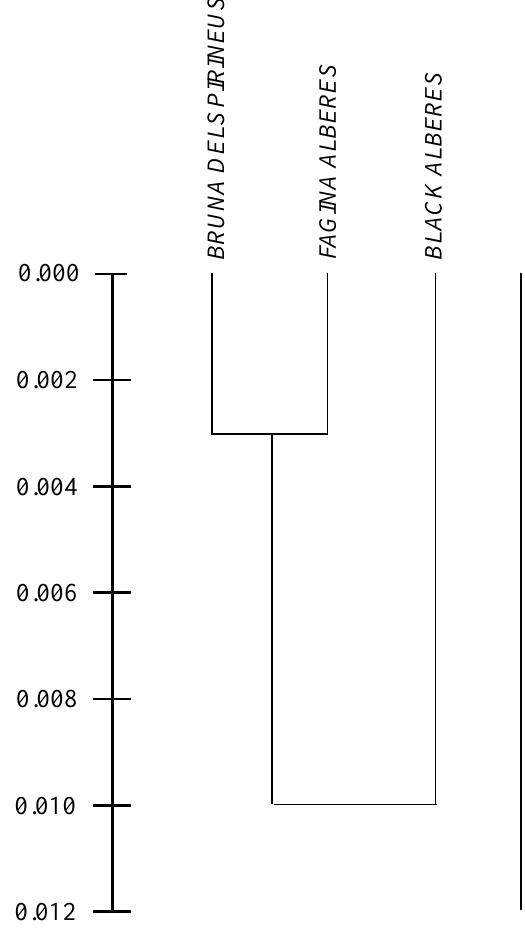
Figure 2 - Phenogram obtained by the UPGMA method using F values, which relates the two varieties of the “Alberes” breed with the outgroup “Bruna dels Pirineus”